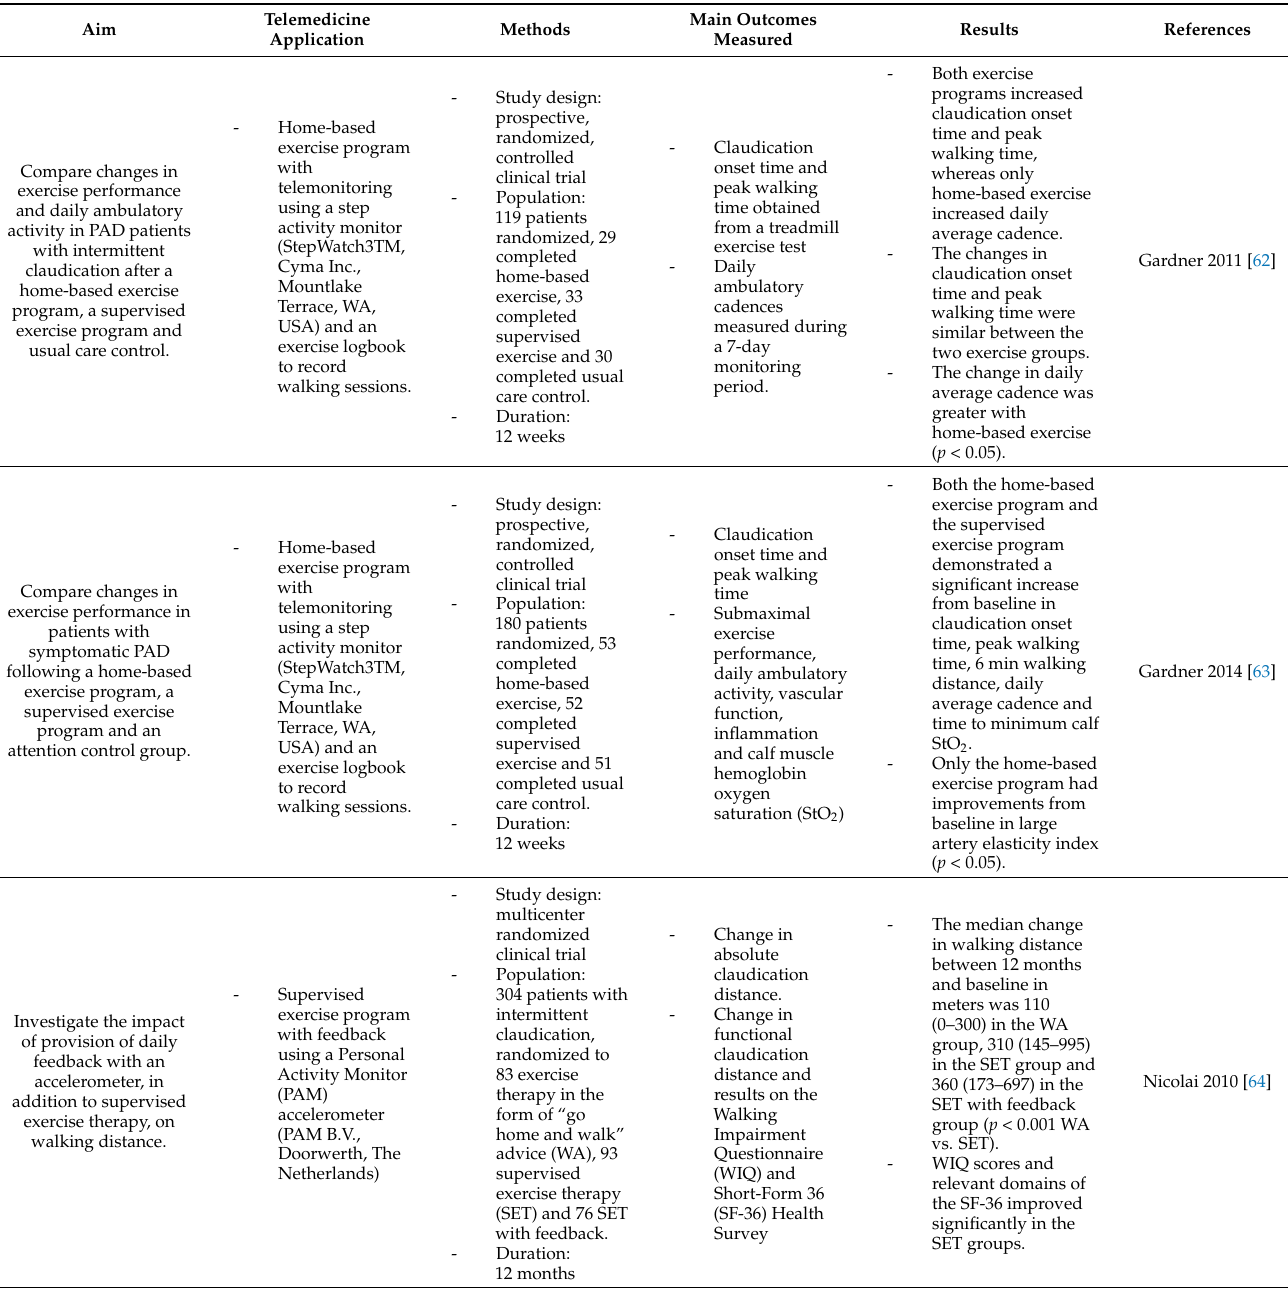
Table 1. Summary of clinical trials investigating the use of telemedicine-enhanced exercise programs for patients with lower extremity artery disease